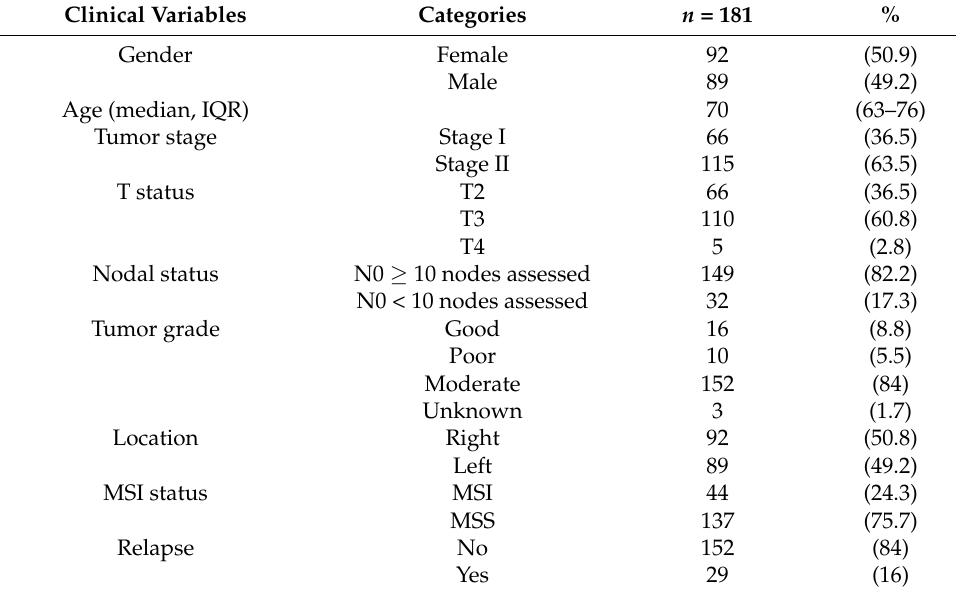
Table 1. Clinical and histopathological